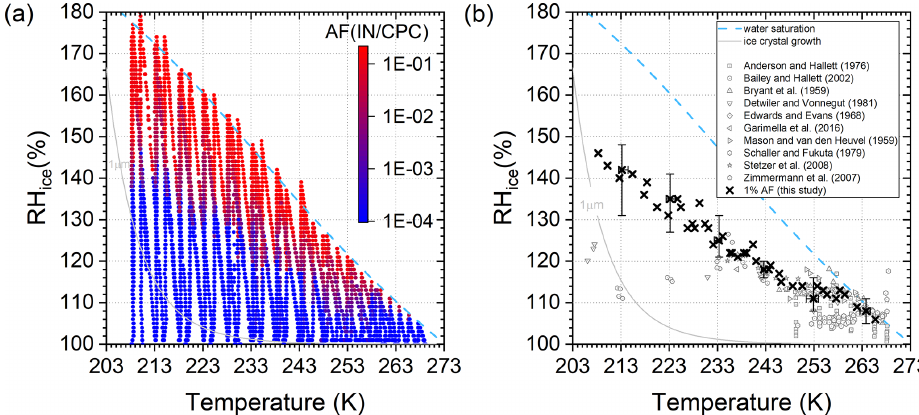
Figure 5. (a) Activated fraction of 200nm AgI particles and (b) 1% AF in comparison to literature data (references indicated in the figure legend). Water saturation and 1µm ice crystal growth conditions are indicated as lines. The range of experimental variability in RH i and T is shown at 10K